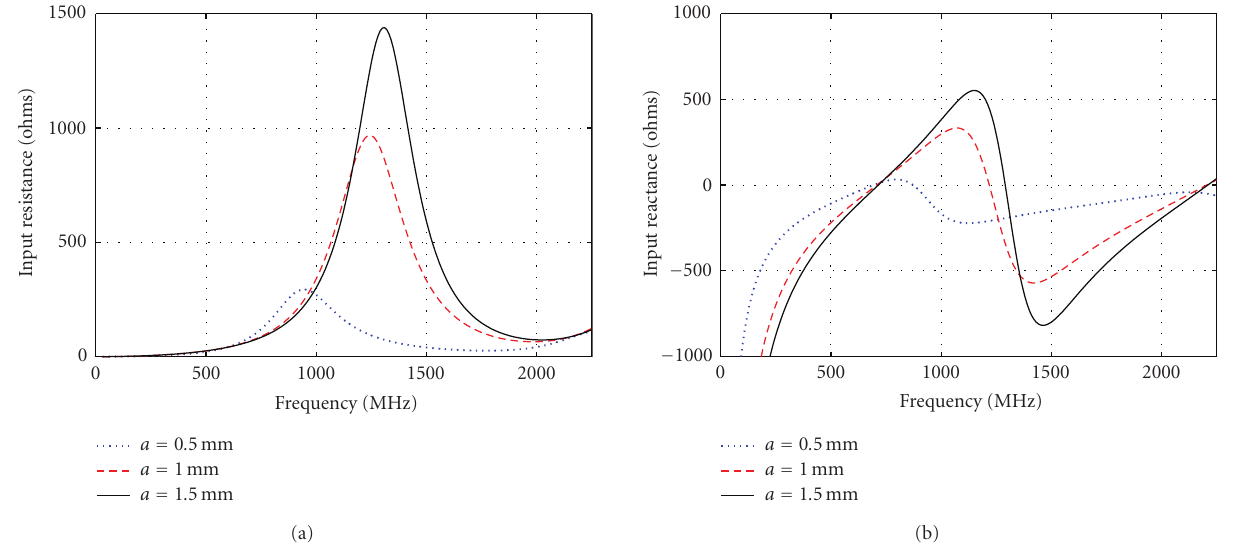
Figure 11: E ff ect of inner shell radius a on antenna input impedance. Other parameters: L = 200 mm, b = 1 . 8542 mm, r = 0 . 3175 mm, = − 1, and N = ε r = μ r